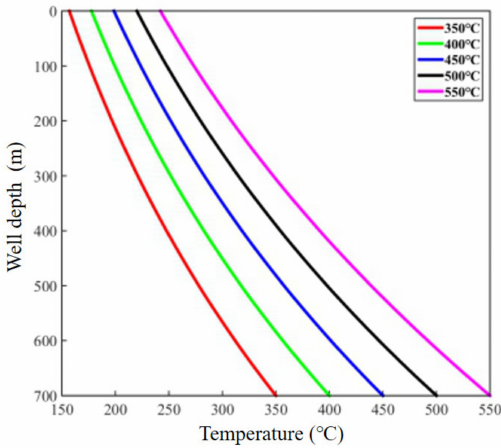
Figure 14. Temperature distribution of produced gas at different spray chamber